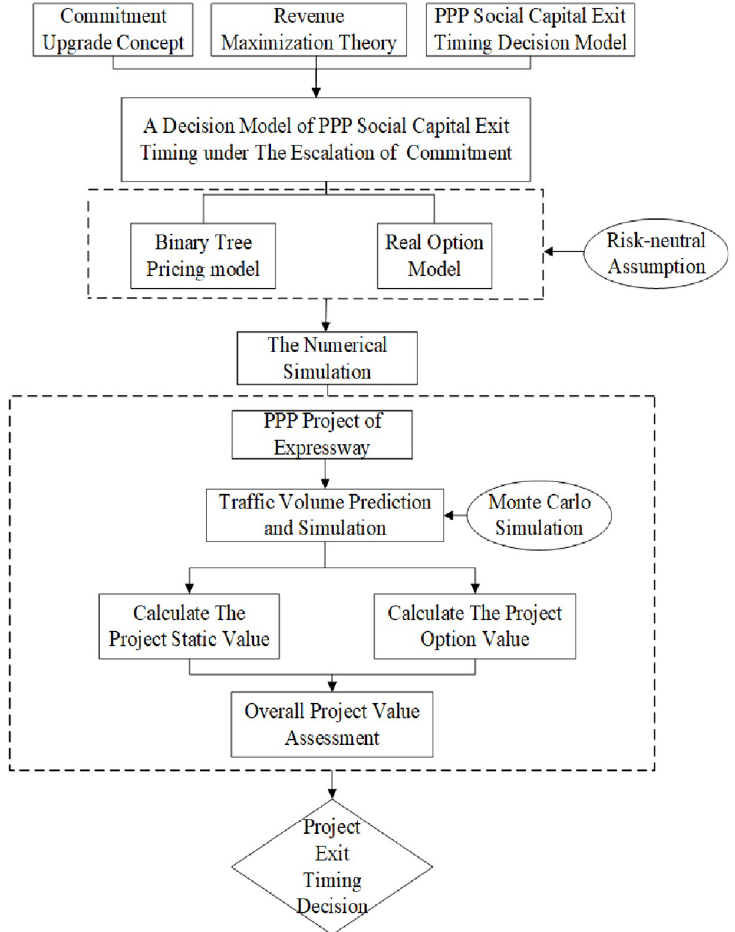
Fig 1. Technology roadmap. (Source: author’s